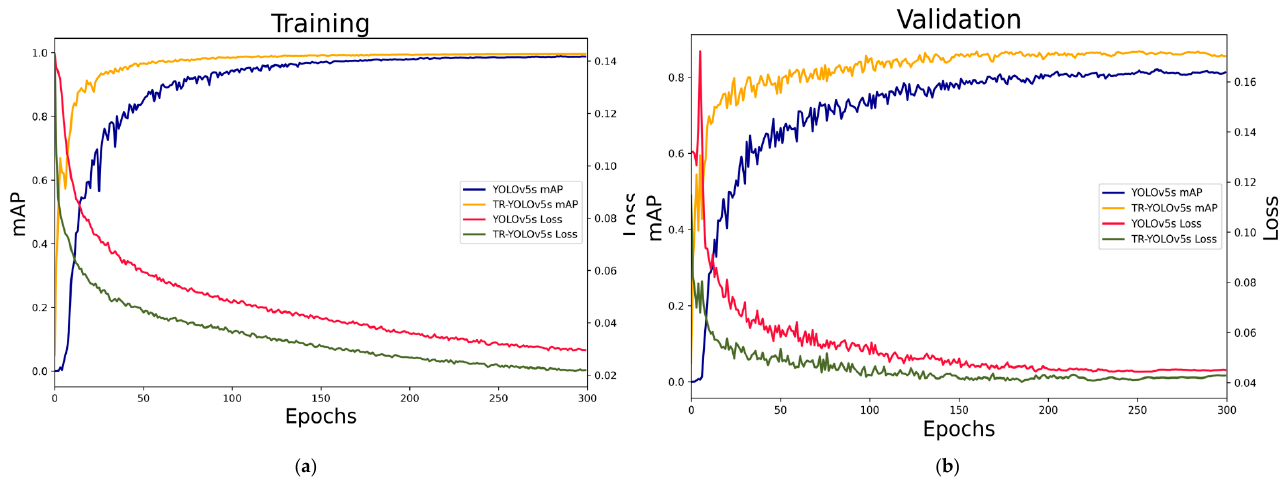
Figure 17. The mAP curves and Loss curves of detectors in the training set and validation set: ( a ) the mAP curves and training loss curves of two detectors; ( b ) the mAP curves and validation loss curves of two detectors.